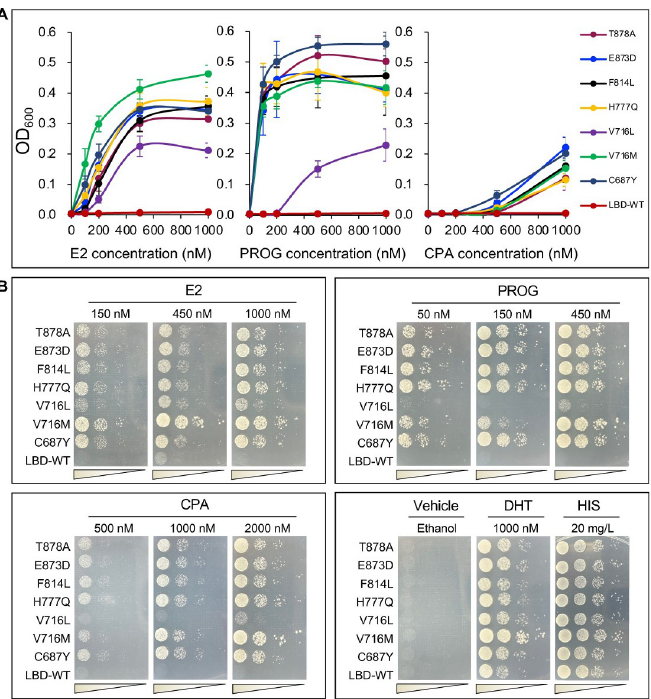
Fig 4. The evaluation of identified AR mutants in a dose-dependent yeast assay against steroidal ligands. ( A ) Liquid dose-dependent yeast assay with 25 mM 3-AT added (n = 5). OD 600 values were measured 48 h post- incubation. Bars indicate mean ± s.d. ( B ) Plate dose-dependent yeast assay with 25 mM 3-AT added. Plates were photographed 48 h post-incubation.